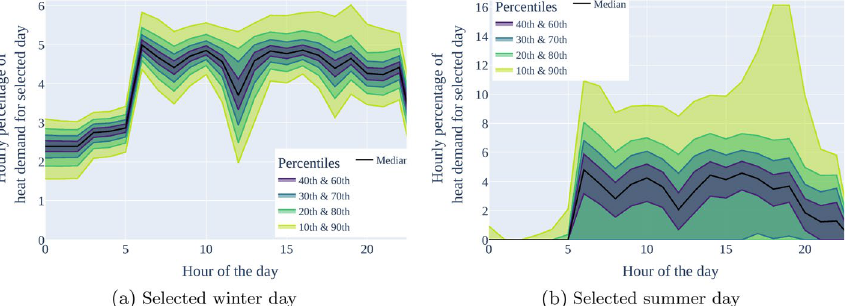
Fig. 7 Heat demand variation of buildings in